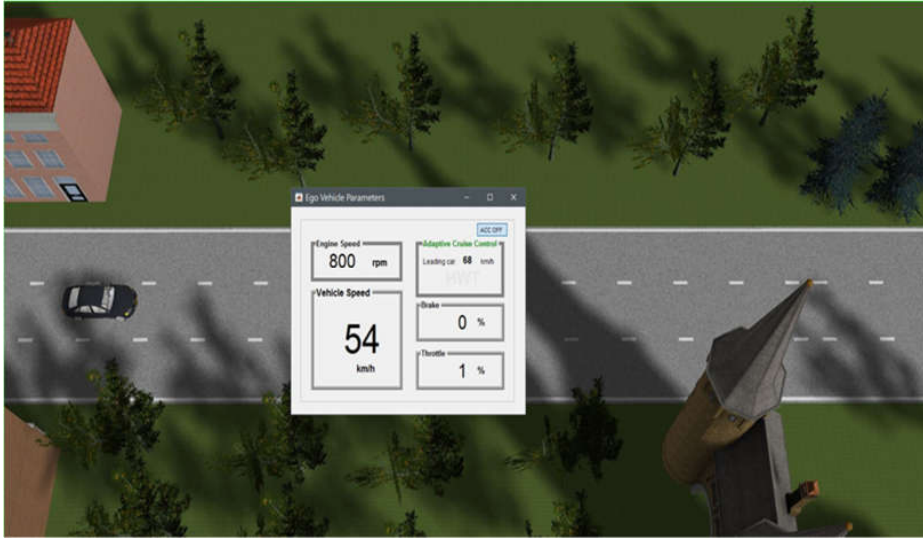
Figure 9. Ego-vehicle parameters showing lower speed of the vehicle A.